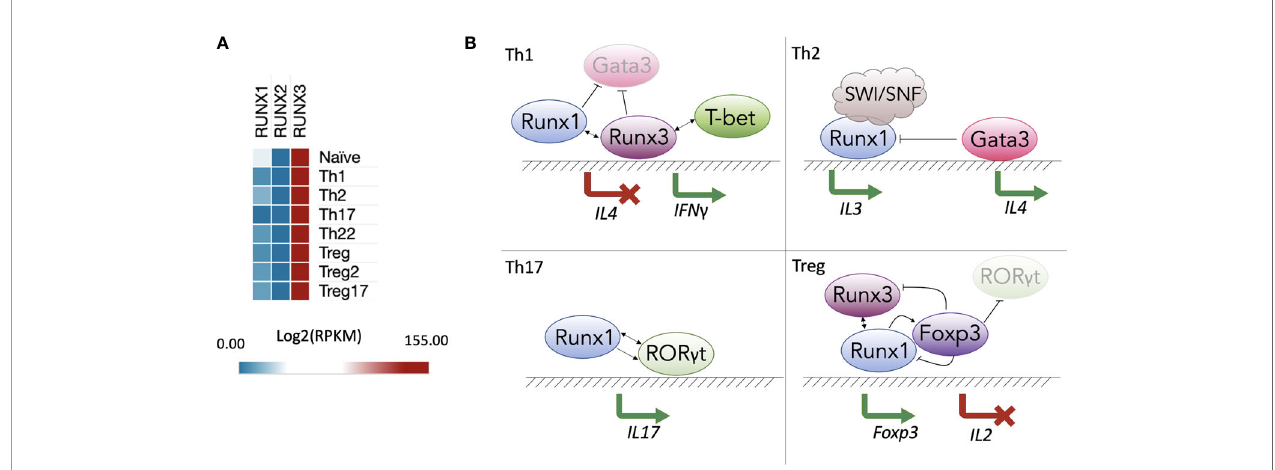
FIGURE 1 | RUNX gene expression and function in T helper populations. (A) Expression of Runx proteins in different Th subsets of human CD4 + T cells (129) (GSE149090) processed in SciDAP (https://scidap.com, Datirium); (B) Runx-mediated Th differentiation. In the Th1 subtype (top left), RUNX1 and RUNX3 compete with GATA3 and suppress expression of Th2-signature cytokines, such as IL-4. RUNX3 and T-bet induce IFNG expression. In the Th2 subtype (top right), RUNX1 interacts with the SWI/SNF complex to induce IL3 . In the Th17 subtype (bottom left), RUNX1 and ROR g t cooperate to induce expression of IL17 . In T regulatory cell (Treg) populations (bottom right), RUNX1 is essential for transcription of FOXP3 , whose protein product forms a complex with RUNX1 and RUNX3 to inhibit